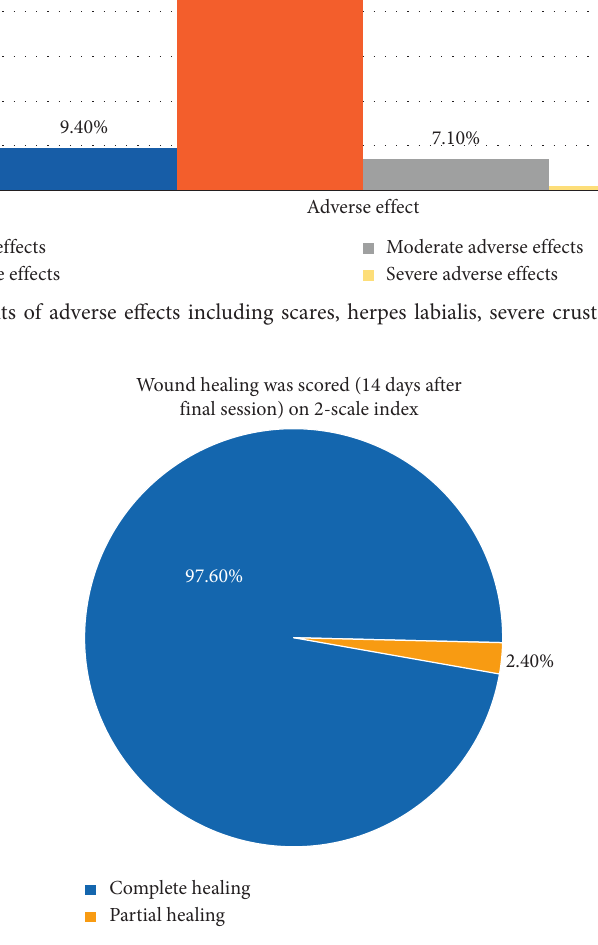
Figure 6: Results of wound healing was scored (14 days after final session) on a 2-scale index.